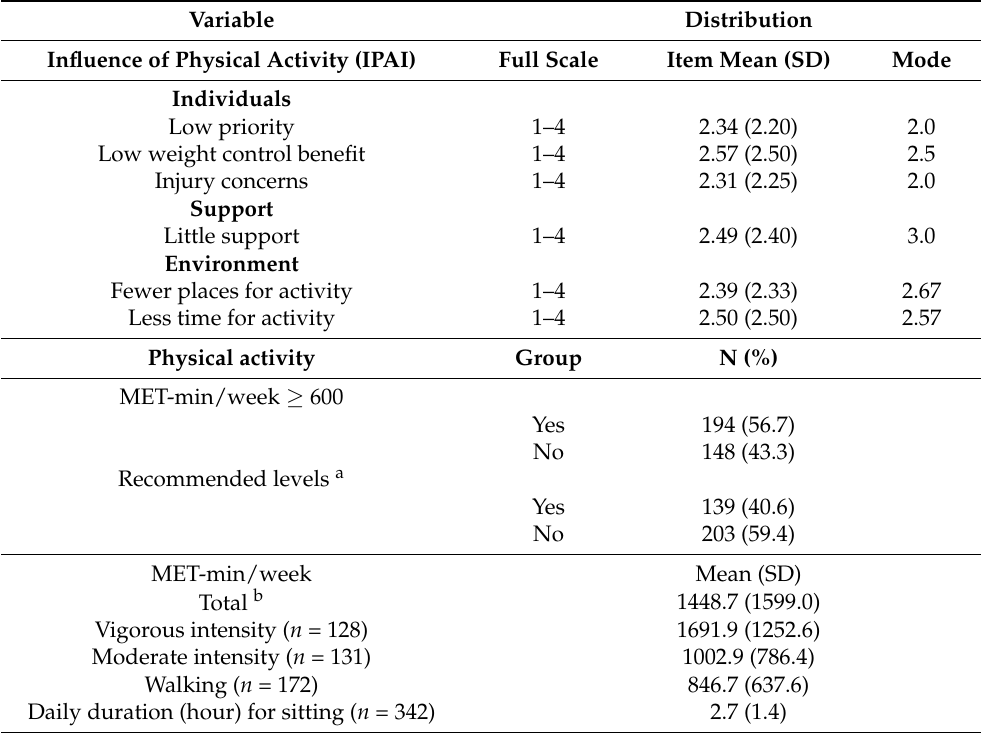
Table 2. Distribution of influences of physical activity and physical activity behaviours ( n = 342).